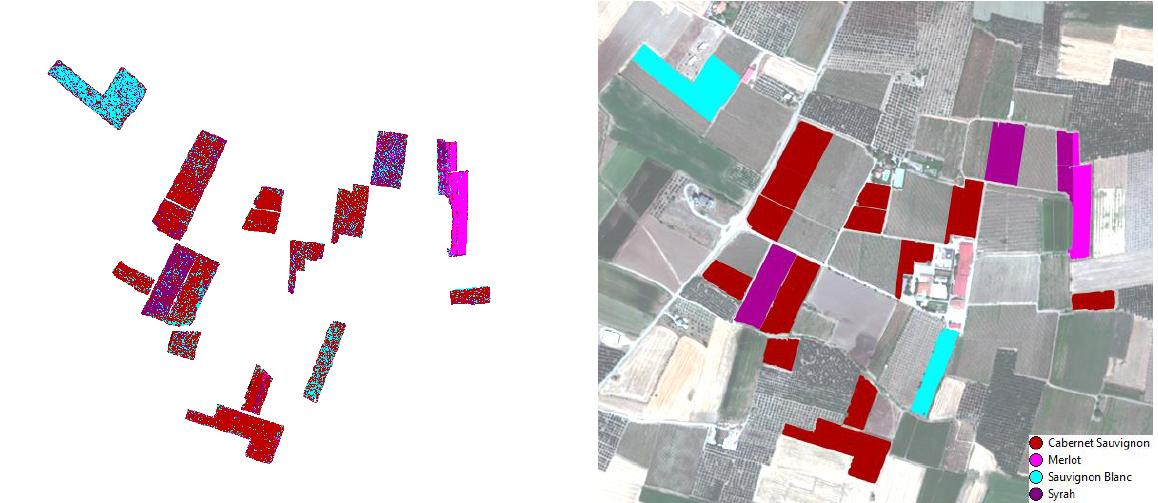
Figure 3. Vine variety discrimination results in the Megaplatanos study area. Four different vine varieties were discriminated i.e., Cabernet Sauvignon, Merlot, Sauvignon Blanc and Syrah. The quantitative evaluation indicated overall accuracy rates of 69% at pixel level and 94% at parcel level.